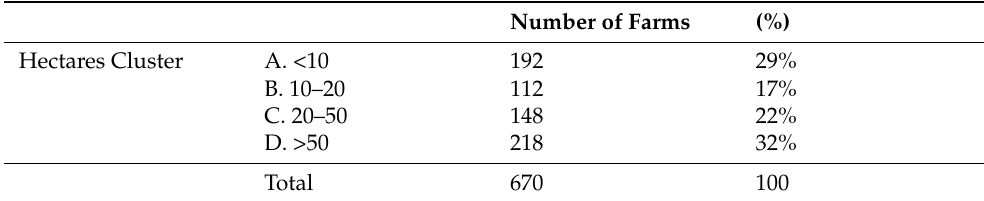
Table 5. Land size cluster distribution in the sample.